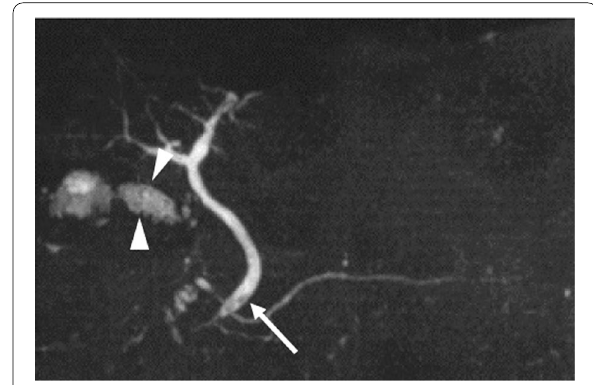
Fig. 2 Magnetic resonance cholangiopancreatography revealed small gallstones in the gallbladder (arrowhead) and common bile duct (arrow)